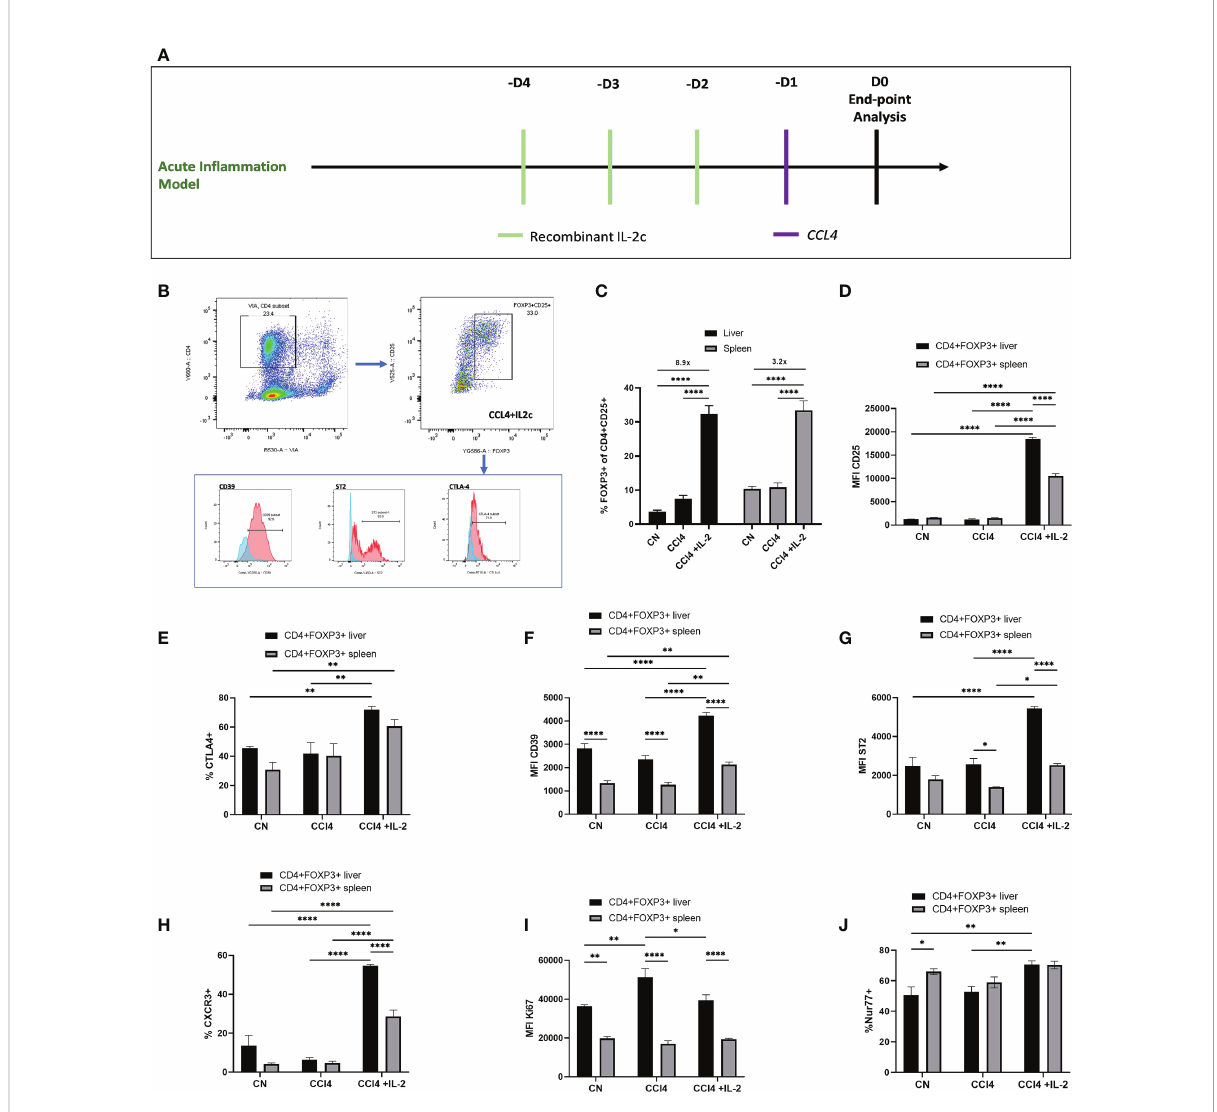
FIGURE 4 IL-2c expanded intra-hepatic Tregs exhibit enhanced expression of immunoregulatory transcripts in the in fl ammation rich microenvironment. (A) Schematic representation of the experimental design to generate CCL ₄ induced acute liver in fl ammation; IL-2c administered for 3 consecutive